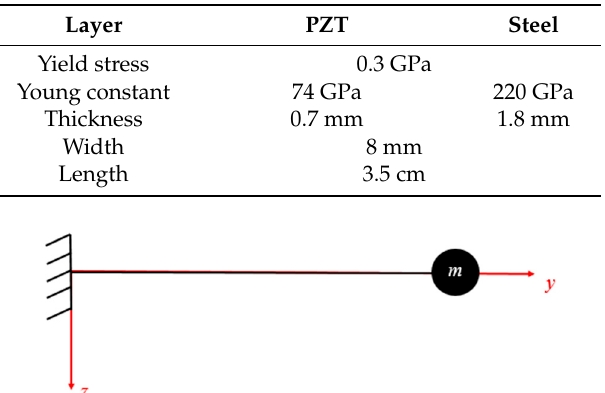
Figure 2. Mono-dimensional scheme of the support with the local coordinate system and the mass corresponding to half the rotor mass concentrated at the free end.